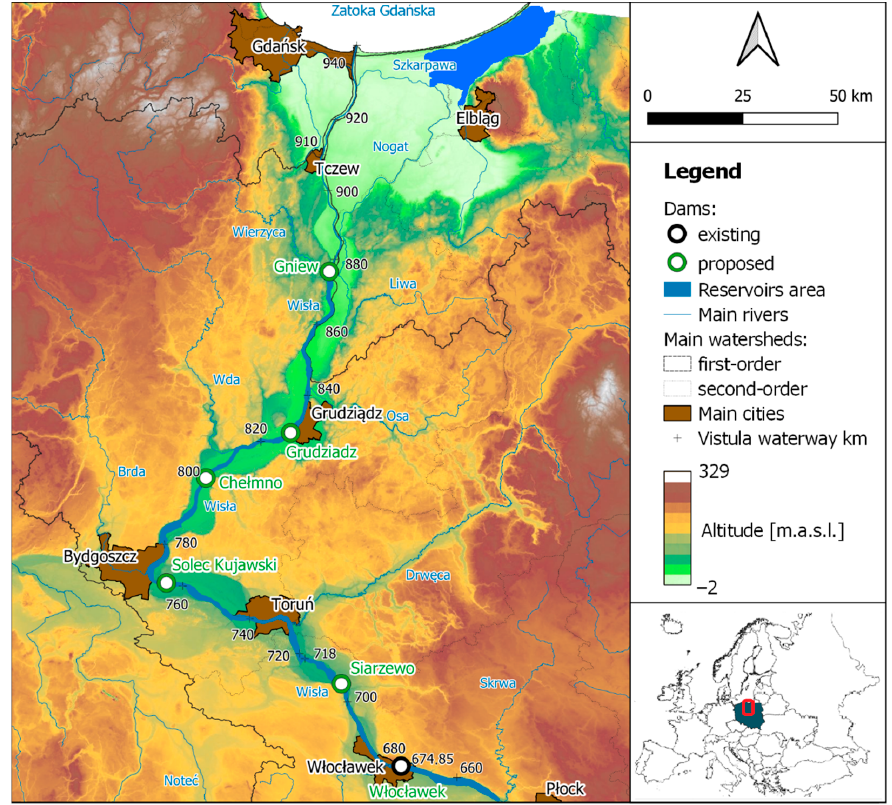
Figure 3. Planned location of new barrages and related reservoirs on the Vistula section from the Włocławek barrage to the mouth of the Gdansk Bay against the background of the numerical terrain model [35]. Source: own study based on the adopted locations and water ordinate [11].